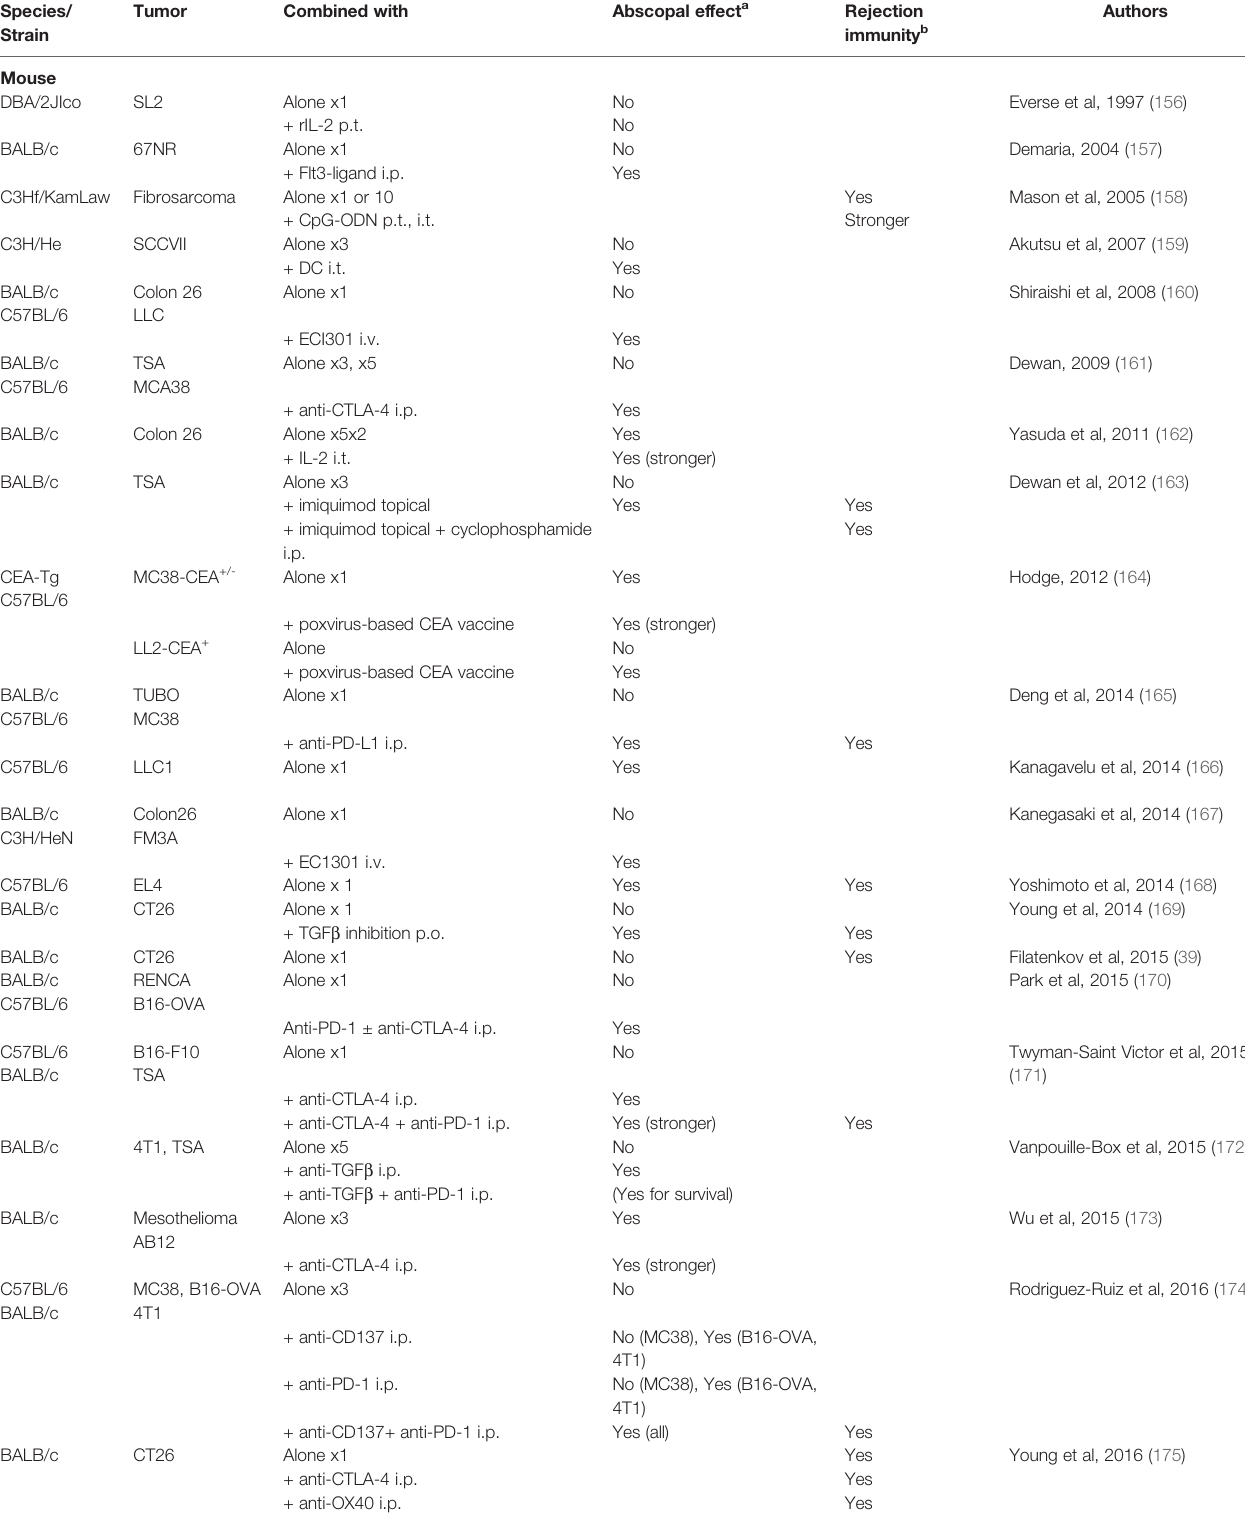
TABLE 4 | Effect on systemic disease after radiotherapy in